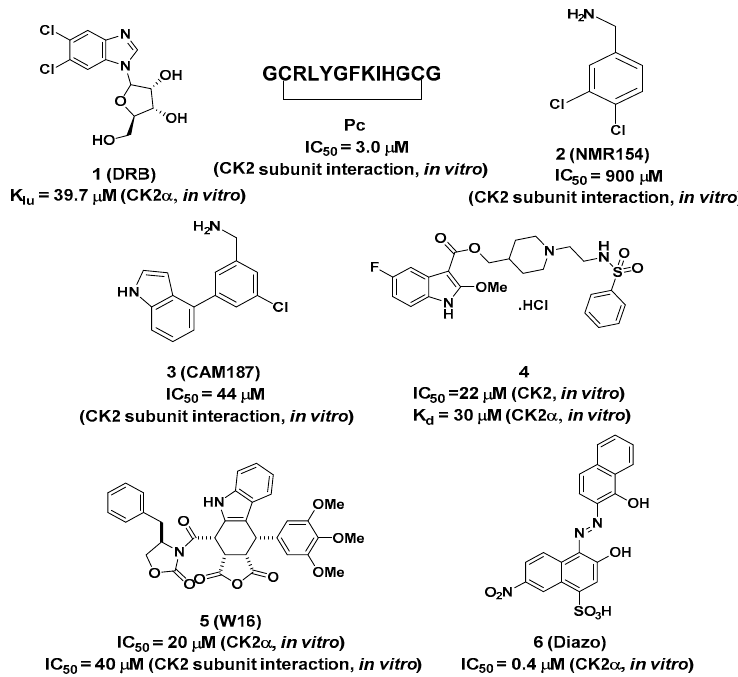
Figure 2. Structures of compounds ( 1, Pc , 2, 3 and 4 ) and allosteric inhibitors ( 5–6 ) binding toSite